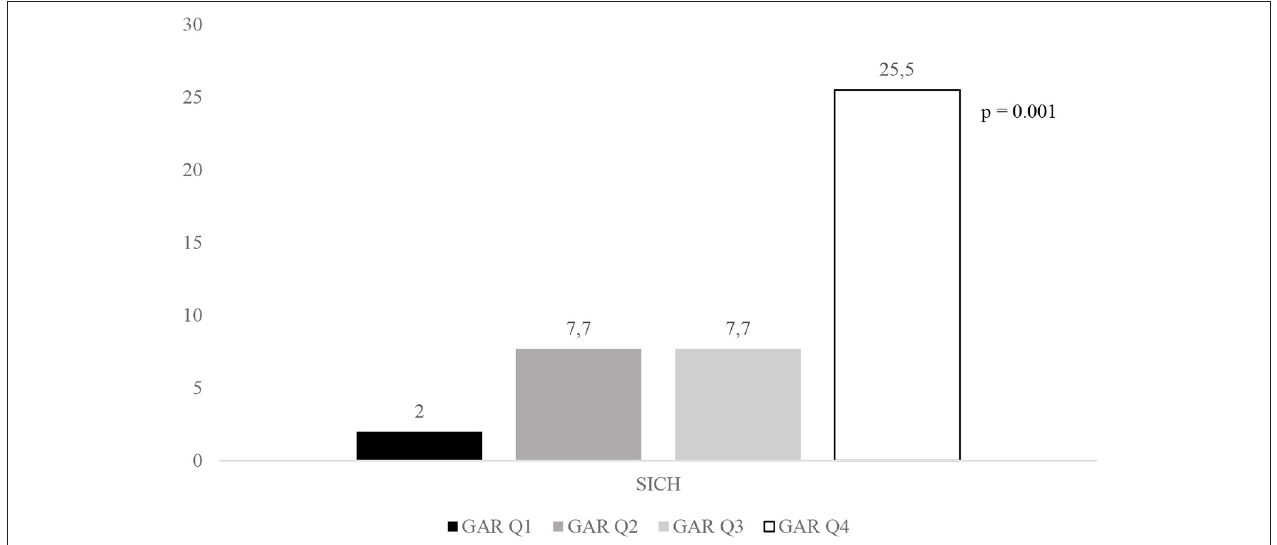
FIGURE 4 | Rates of SICH according to GAR quartile. SICH, symptomatic intracranial hemorrhage; GAR Q1, first glucose-to-glycated hemoglobin ratio quartile; GAR Q2, second glucose-to-glycated hemoglobin ratio quartile; GAR Q3, third glucose-to-glycated hemoglobin ratio quartile; GAR Q4, fourth glucose-to-glycated hemoglobin ratio quartile.